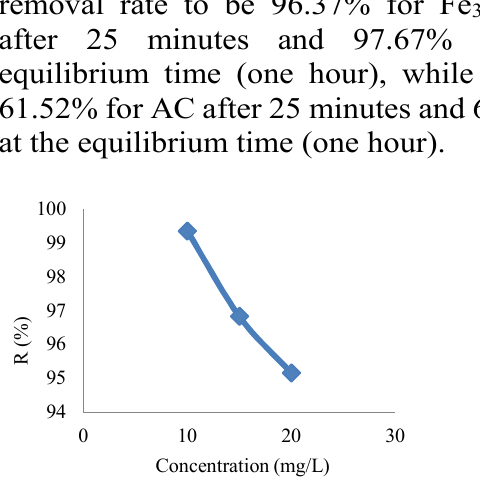
Fig. 5. Removal rate of Cu +2 at variable